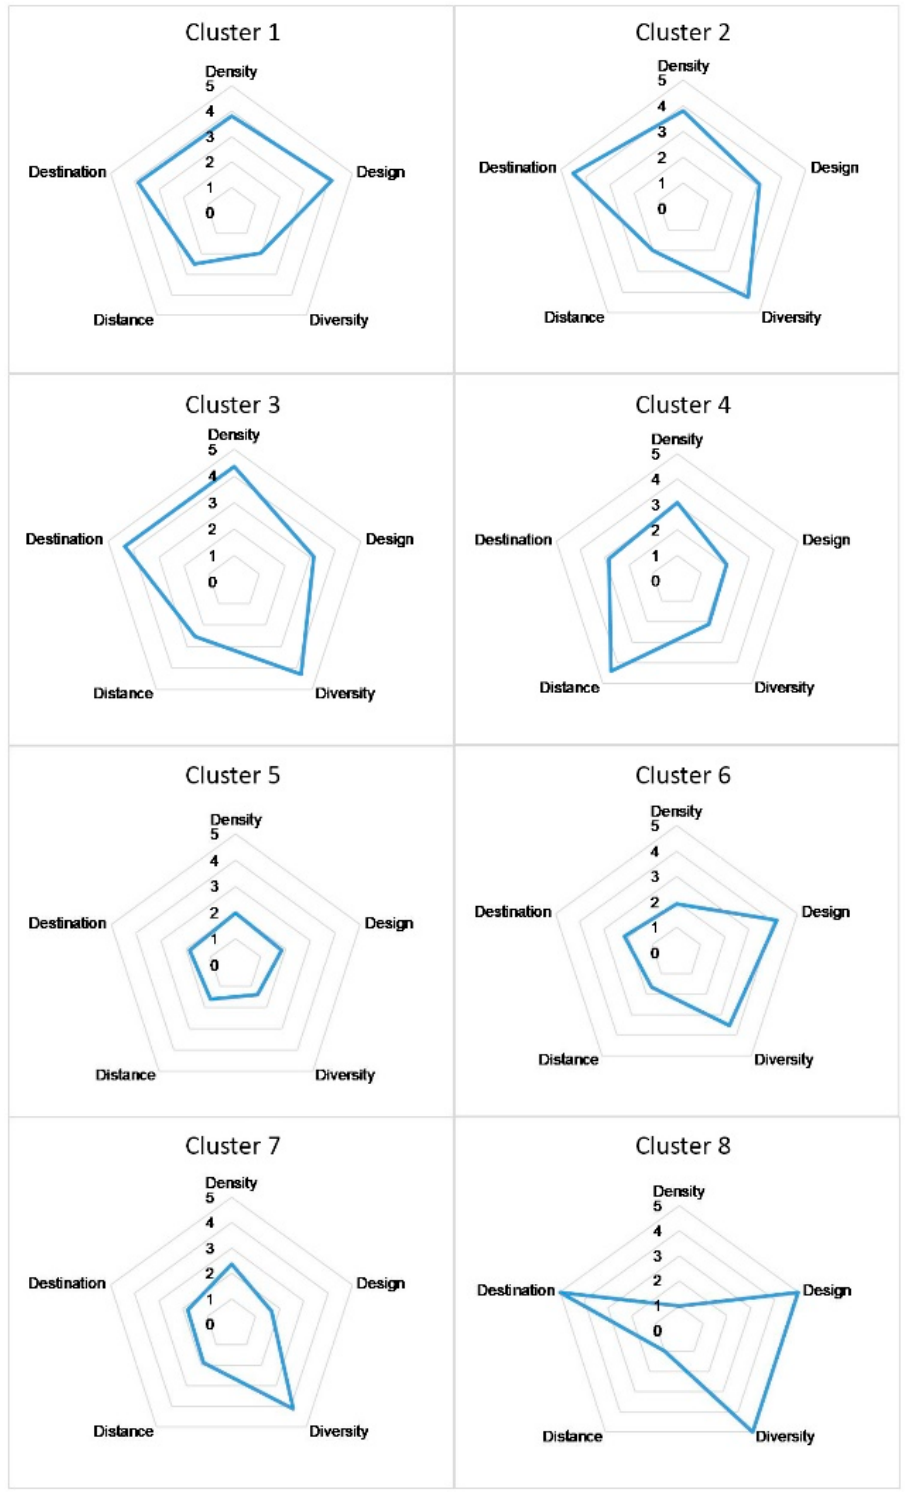
Figure 14. Radar charts displaying the average score for each variable by group.